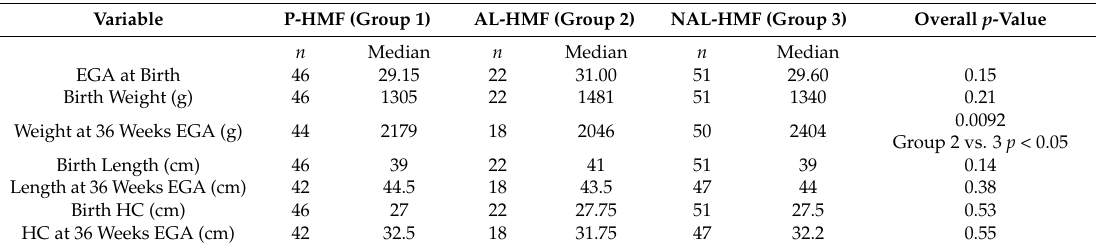
Table 2. Baseline characteristics of subjects by